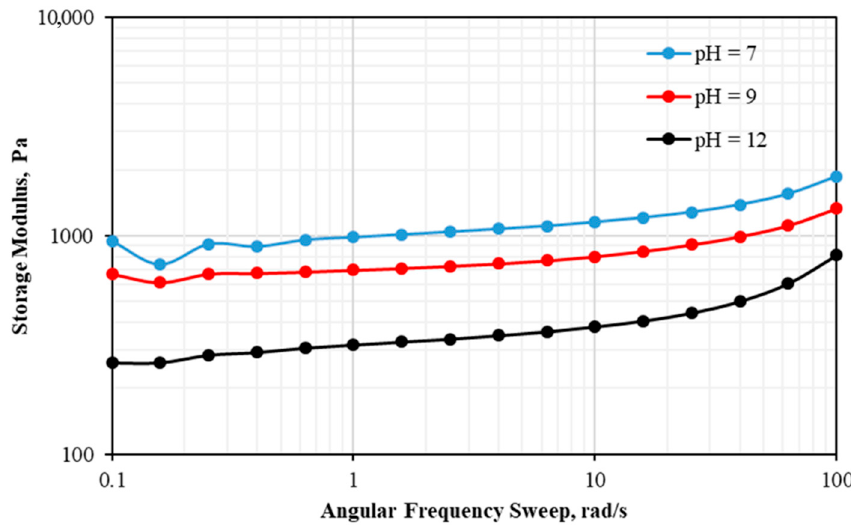
Figure 11. Effect of pH on the storage modulus of gels composed of 3.5% CuAc/9% PAM (25 °C).